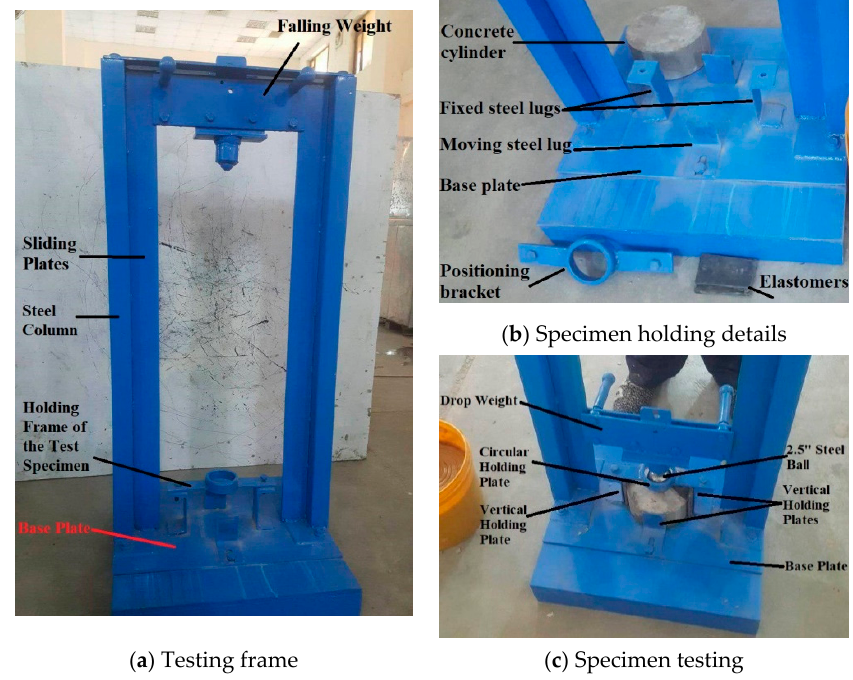
Figure 3. The used RDMI testing apparatus.